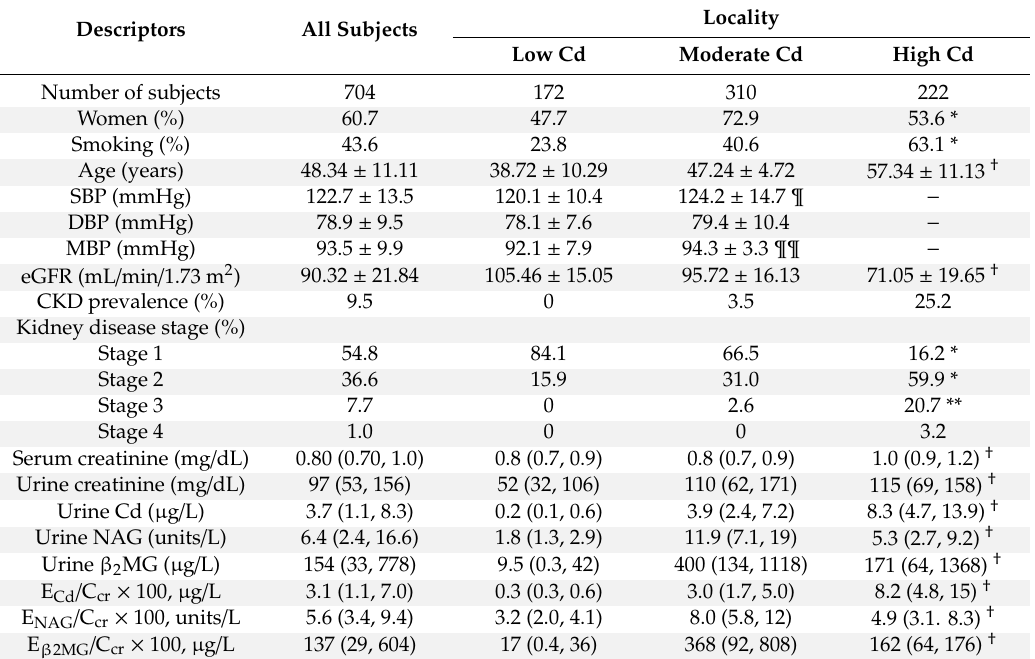
Table 1. Study subjects drawn from three